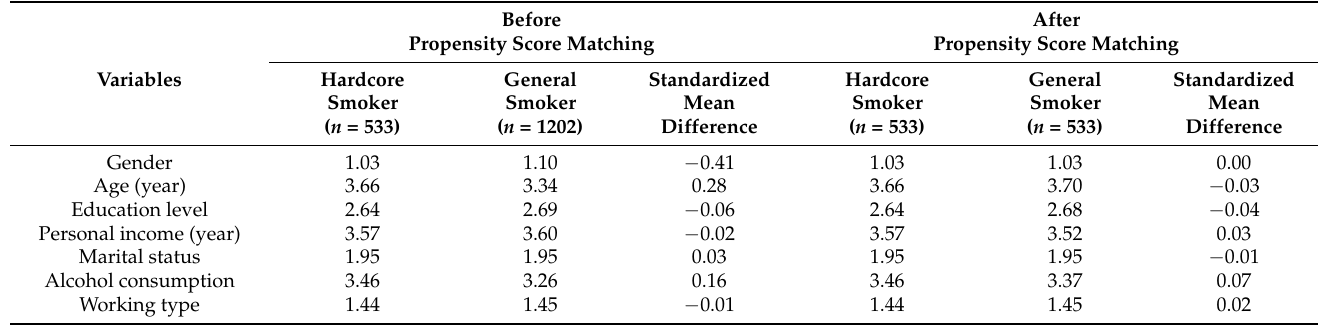
Figure 1. Data balance after propensity score matching. X1 = Gender, X2 = Age, X3 = Education level, X4 = Personal income, X5 = Marital status, X6 = Alcohol consumption, X7 = Working type. Table 2. Data balance after propensity score matching.